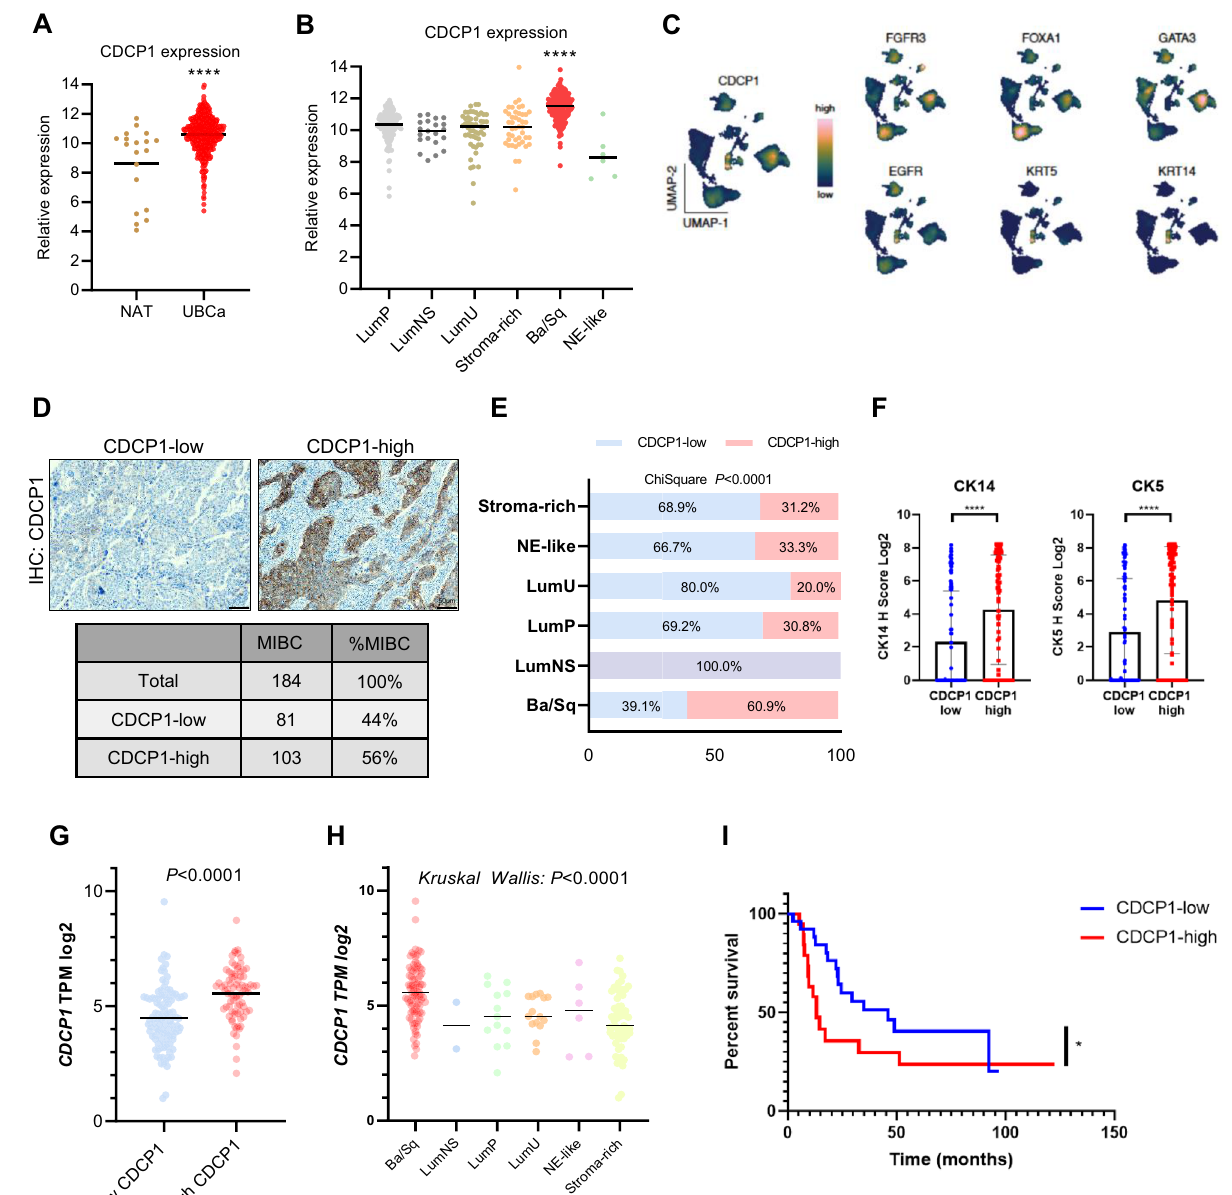
Figure 2. CDCP1 expression is elevated in advanced UC and enriched in Ba/Sq subtype. ( A ) Expressional levels of CDCP1 in UC tissue compared to NAT. Data obtained from the TCGA BLCA data set. ****P < 0.0001. Statistical test: two-tailed unpaired t test. ( B ) Comparison of CDCP1 levels between the UC molecular subtypes from TCGA BLCA data set. ****P < 0.0001. Statistical test: one-way analysis of variance. ( C ) Visualization via scRNAseq analysis of the expressional levels of CDCP1, and different Lu subtype molecular markers (FGFR3, FOXA1, GATA3) and Ba/Sq subtype molecular markers (EGFR, KRT5, KRT14) in the UC cohort from Chen et al., 2020. ( D ) Representative images of tumors from the MIBC TMA showing tumors with CDCP1-low and CDCP1-high. Table showing the total number of MIBC tumors, CDCP1-low and CDCP1-high. ( E ) Percentage of tumors from the MIBC TMA which show a low or high CDCP1 expression, clustered on the base of the UC subtype. ( F ) Bar graphs indicating the expression of CK5 and CK14 in CDCP1-high tumors compared to CDCP1-low tumors. The expression is evaluated by IHC in the MIBC TMA. Error bars indicate SD. ****P < 0.0001. Statistical test: two-tailed unpaired t test. ( G ) Transcriptional expression of CDCP1 (TPM: transcripts per million reads) compared to CDCP1-low and CDCP1-high levels in the MIBC TMA confirming the correlation between CDCP1 transcripts and protein levels. ( H ) CDCP1 TPM across the UC subtypes showing the high expression of CDCP1 in the Ba/Sq subtype. Tumor samples are correspondent to the ones from the MIBC TMA. ( I ) Kaplan–Meier survival analysis of UC patients treated with chemotherapy stratified based on the semi-quantitative expression of CDCP1 (CDCP1-low: negative, weak; CDCP1-high: moderate, strong). *P < 0.05. Statistical test: Gehan–Breslow–Wilcoxon